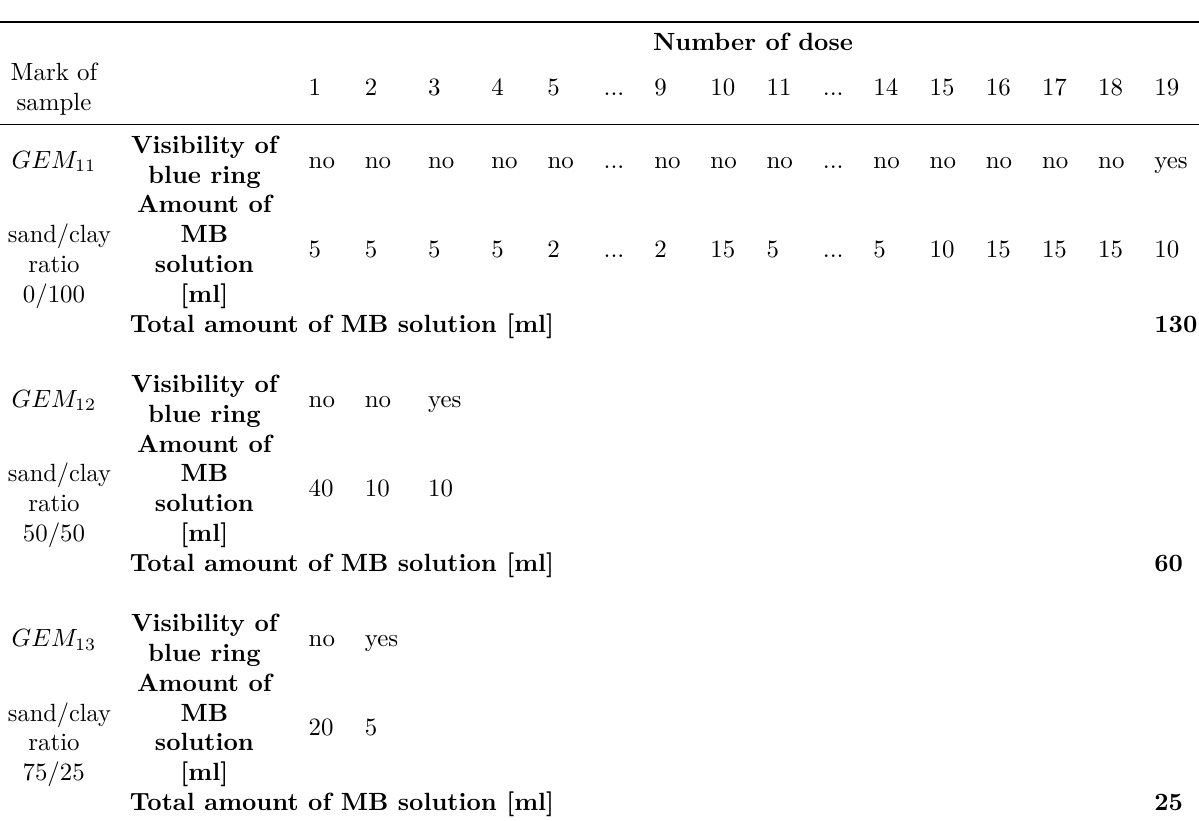
Table 3. Doses of methylene blue solution to GEM earth sample where stirring time 1 minute is used for each 1 ml of MB solution in earth